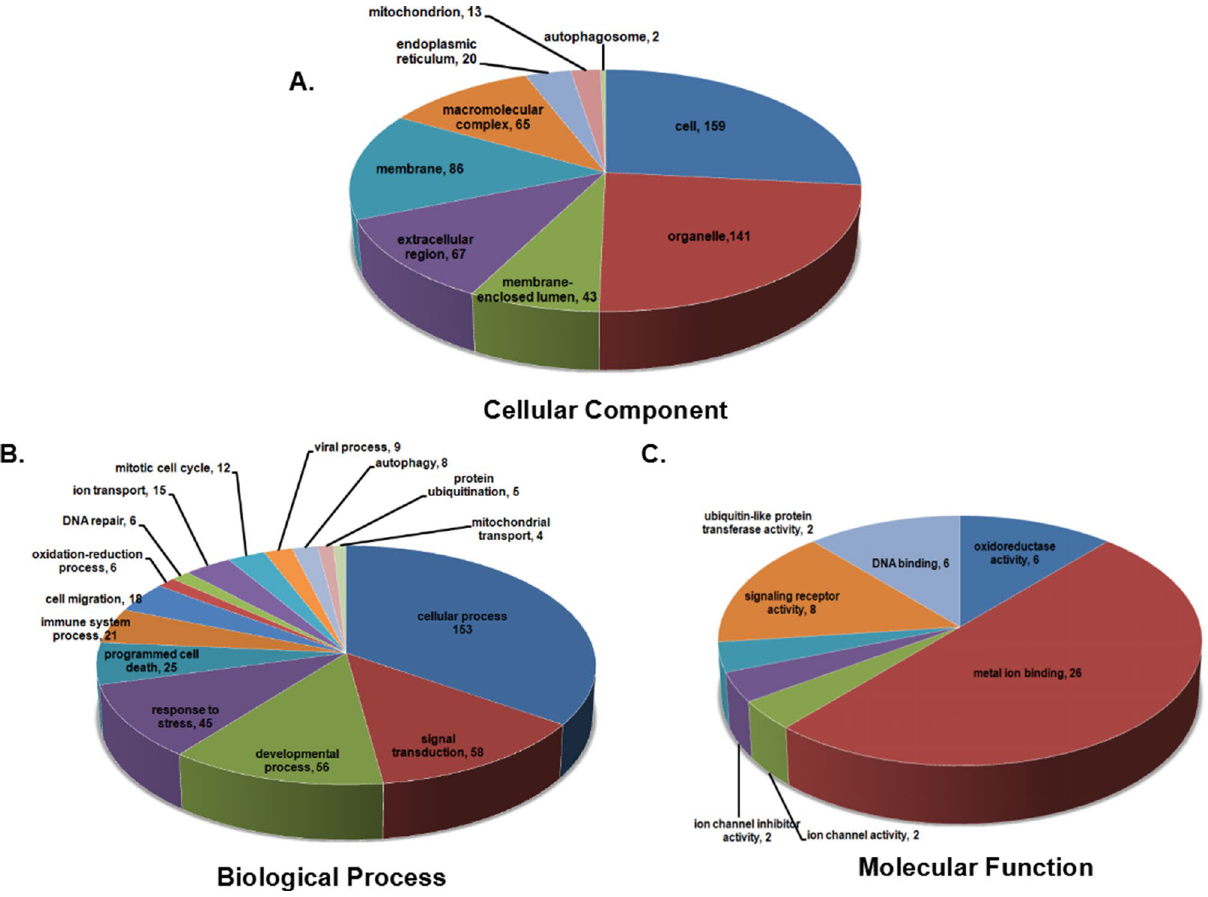
Figure 2. GO terms distribution. GO terms distribution in the cellular component ( A ), biological process ( B ) and molecular functions ( C ). In ( A ), the most represented categories were cell and organelle. In ( B ), cellular process and signal transduction were the most represented biological processes. In ( C ), the most represented molecular functions were metal ion binding and signaling receptor activity (http:// www. geneo ntolo gy. cellular components category, the results suggested most of the potential biomarkers are concentrated in the cell compartment (26.68%), organelle (23.66%) and the membrane (14.43%) compartments. In the biological pro- cess analysis, most of the DEPs participate in cellular processes (34.69%), signal transduction (13.15%), devel- opmental process (12.70%), and response to stress (10.20%). In the category of molecular function, the DEPs were found to play a role in metal ion binding (50.00%), signaling receptor activity (15.38%), and DNA binding (11.54%), suggesting that their related functions were important in the process of JS-K against HepG2.2.15 cells.